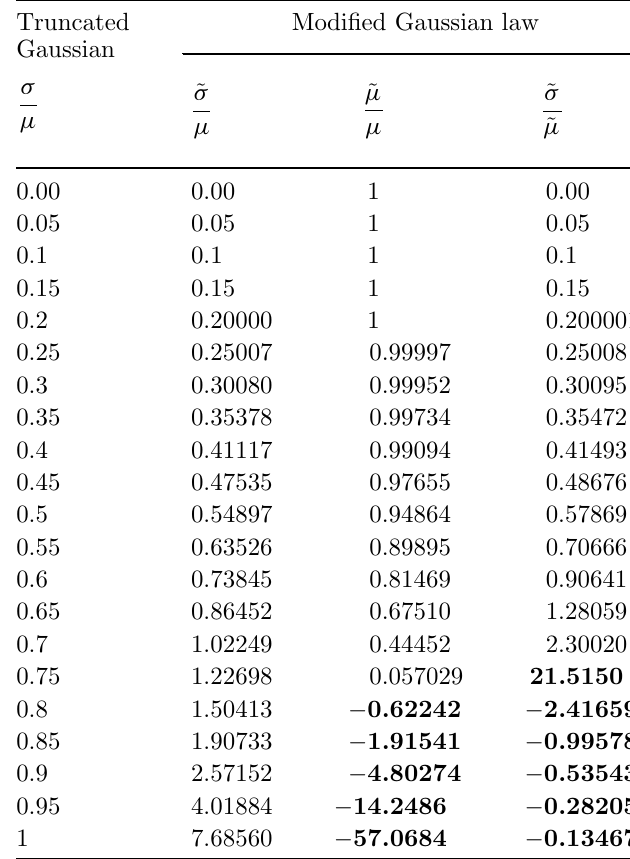
Table 2. Gaussian distribution parameters for correct mean and standard